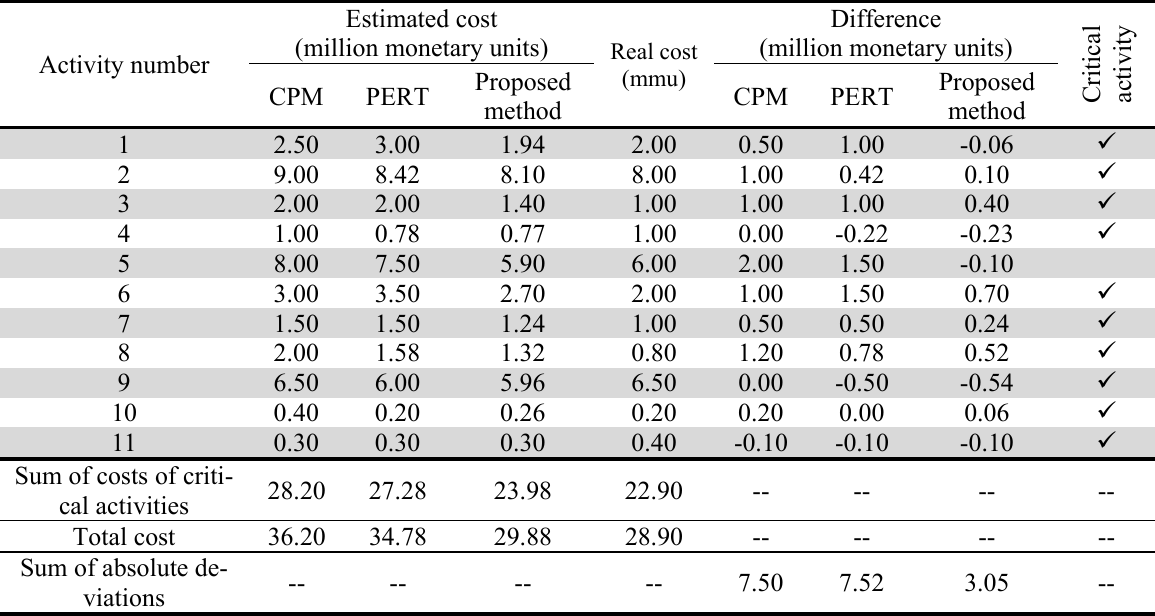
Table 7 Validating the results of CPM, PERT and proposed method for calculating the cost of activities Activity number